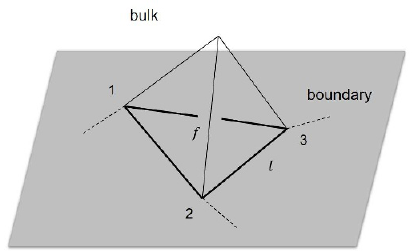
Figure 5. The boundary is the grey plane, above which is the bulk. A bulk tetrahedron and a boundary face f = 123 is explicitly shown. The dashed lines represent the rest of the graph that is now